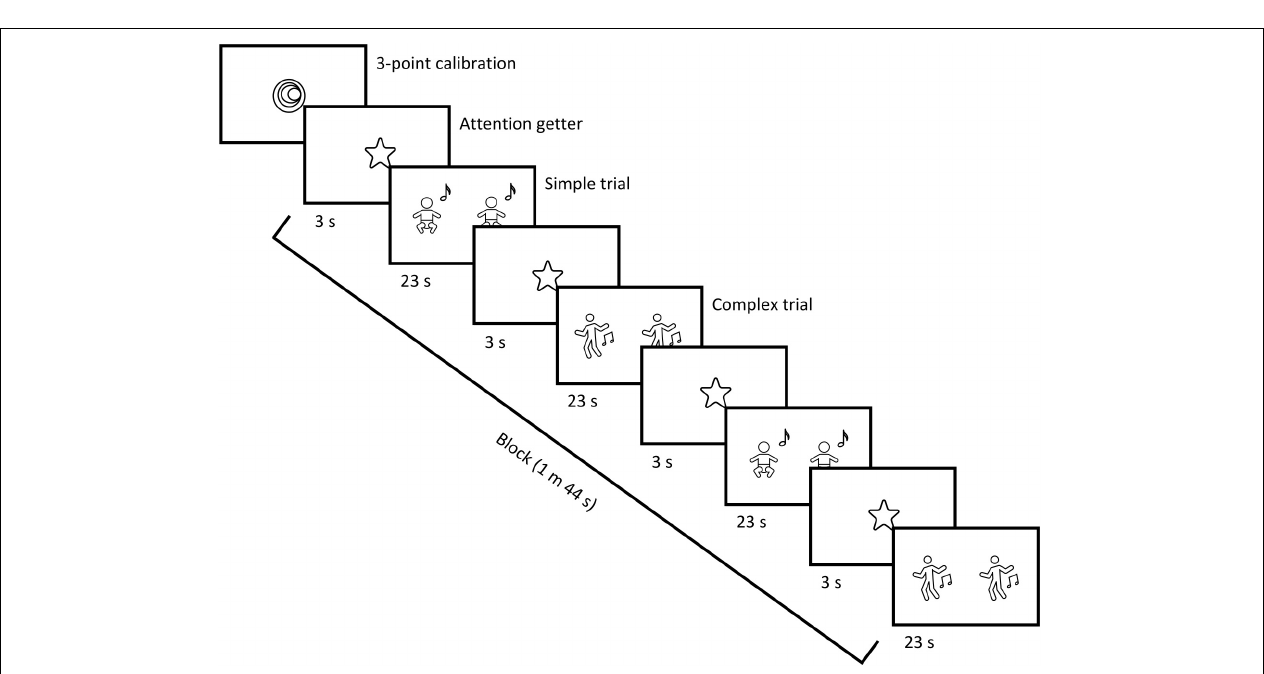
FIGURE 1 | Simple and complex stimuli during an experimental trial. (A) In the trials of the simple condition, the audio-visual stimuli were two side-by-side videos of an unfamiliar infant being bounced rhythmically to a simple version of a children’s song. (B) In the trials of the complex condition, the stimuli were two side-by-side videos of an unfamiliar woman dancing to the complex version of the same children’s song. In each trial of both conditions, one video was synchronous while the other one was asynchronous with the song; and the positions of the two videos (left/right) were pseudo-randomized across trials.